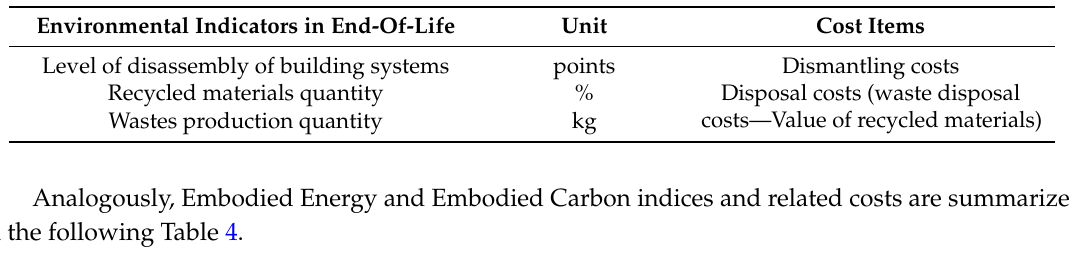
Table 3. Summary table of environmental indicators in end-of-life stage and relative cost items.